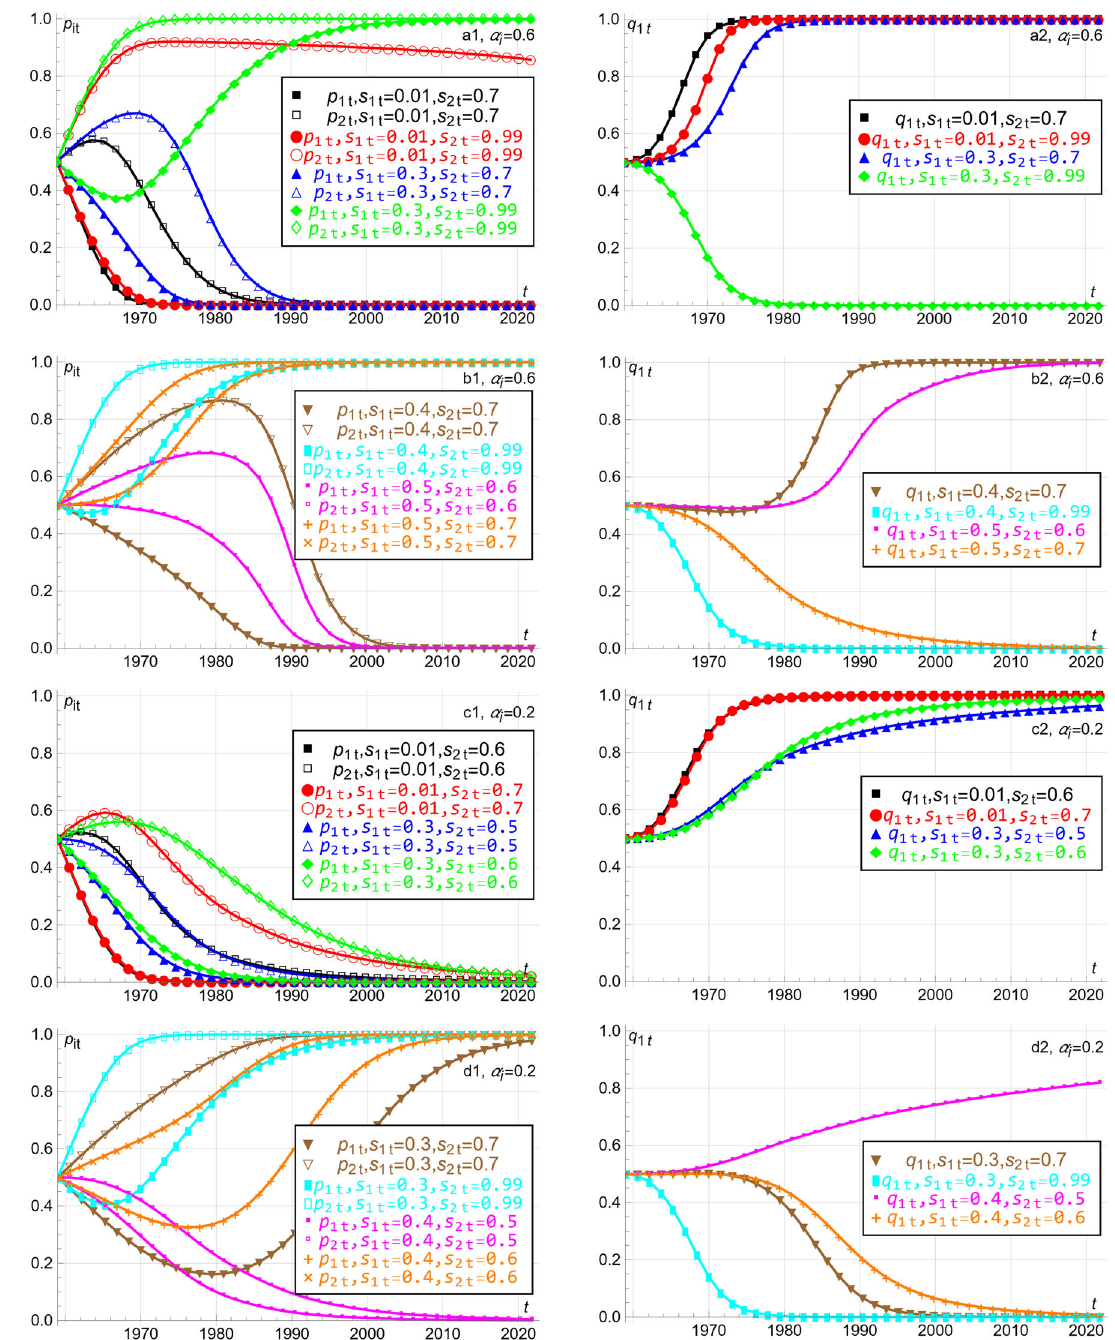
b 1, b 2 α i ¼ 0 : 6. c 1, c 2, d 1, d 2 α i ¼ 0 :